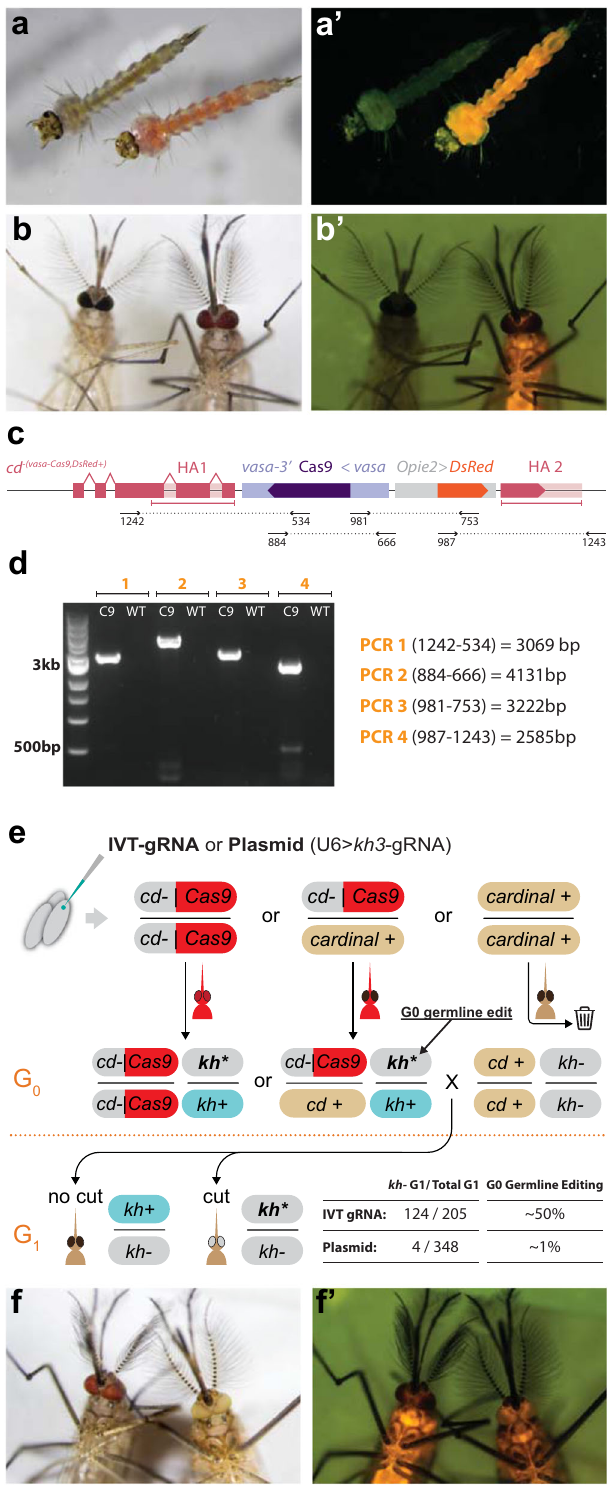
Fig. 3 Phenotypic, molecular, and functional validation of the vasa -Cas9 transgene. a , b ′ Phenotypes of homozygous vasa -Cas9 (right) compared to wild-type (left). Individuals display the cardinal − eye phenotype and the DsRed fl uorescence marking the transgene in both ( a , a ′ ) larvae and ( b , b ′ ) adults. a , b Bright fi eld image. Note how the expression of the transgene is visible as pink pigmentation, observable to the naked eye. a ′ , b ′ DsRed fl uorescence fi lter. c Representation of the transgene inserted within the cardinal open reading frame and the primers used to generate the four diagnostic amplicons. d Gel electrophoresis of the diagnostic amplicons. C9 Cas9, WT wild-type. e Experimental outline of the functional validation of the Cas9 transgenic by injection of eggs with either in vitro transcribed (IVT) kh3 -gRNA or a plasmid expressing kh3 -gRNA. Cas9-positive animals were crossed to a kh − line to evaluate gRNA activity in the G1. The editing rate observed for either IVT-gRNA or plasmid is reported. kh + wild-type kh allele, kh − mutant kh allele coming from the homozygous kh − /kh − line, kh* mutant kh allele generated in the G0 germline by Cas9-directed cleavage. A control male from the injected Cas9 line (left) compared to a DsRed + , kh